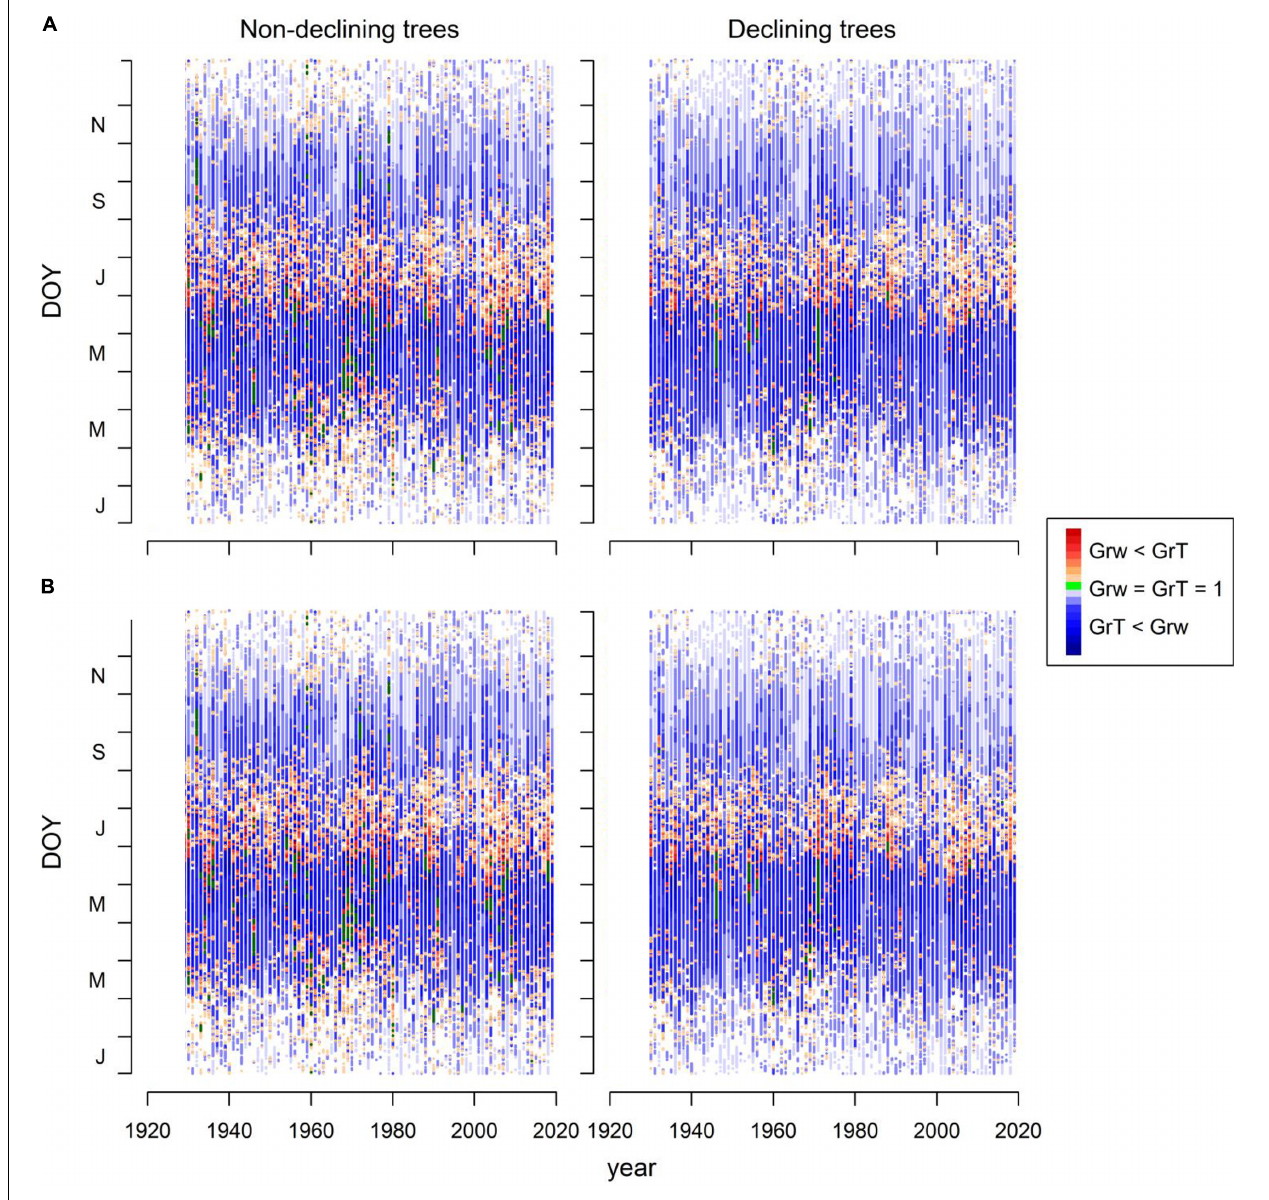
FIGURE 5 | Simulated radial growth rates (Gr) based on the fits of the VS model to mean series of RWI of ND and D trees in the Orera (A) and Miedes (B) study sites. The graphs show the growth function (Gr) values for each day of the year (DOY, Y -axis) and considering the period 1930 – 2019 ( X -axis). Plotted values are classified according to soil-moisture (Gr W < Gr T , orange-red symbols) or temperature limitation of growth (Gr T < Gr W , blue symbols). The green symbols indicate optimal growing conditions (Gr T = Gr W =